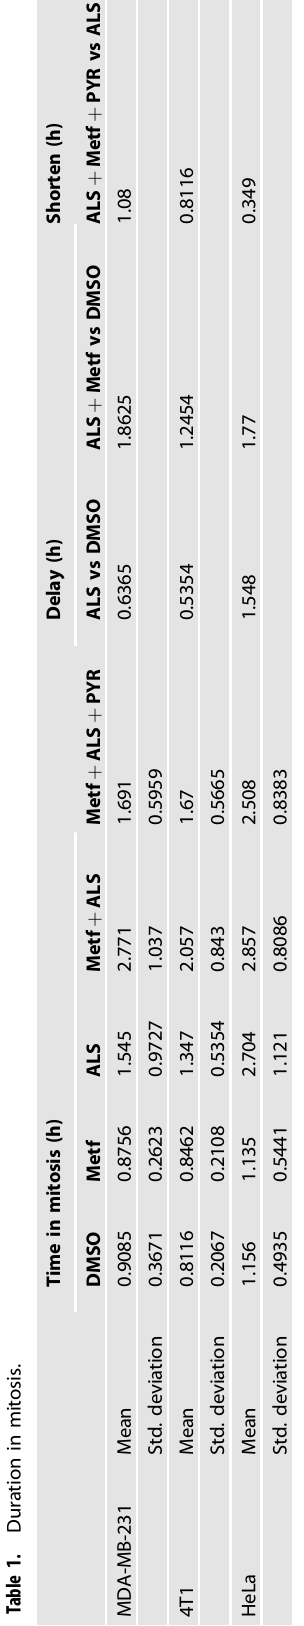
bottom assay plate (Corning, 3917) followed by incubation for 15 min at room temperature. Luminescence was monitored by a microplate reader (Tecan Spark, TM10M) at 560 nM at room